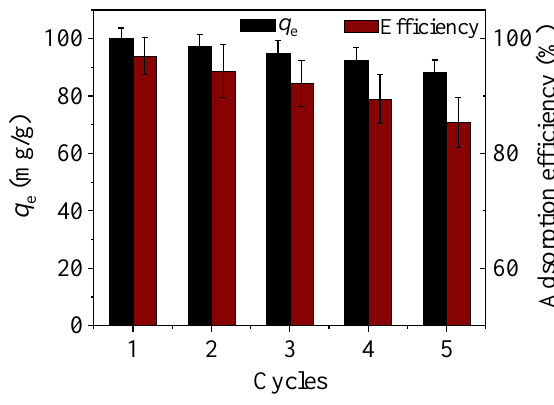
Figure 15. Regeneration cycle of CoFe 2 O 4 @SiO 2 -EDTA.